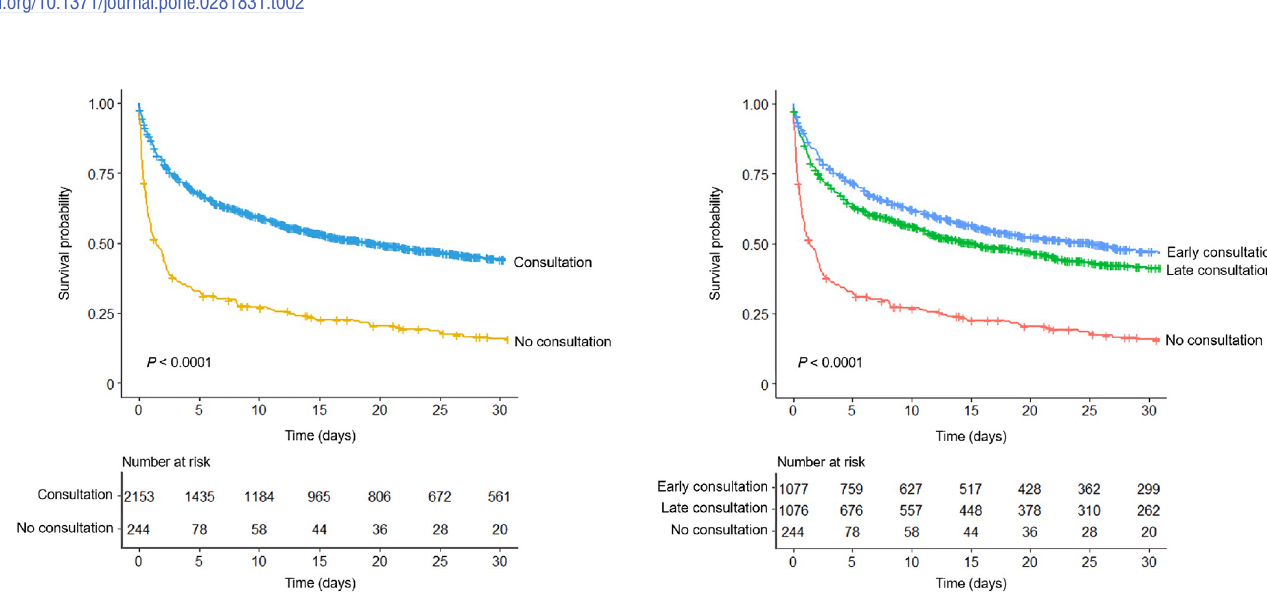
Fig 2. Kaplan–Meier survival curves (A) between consultation and no consultation groups or (B) among early and late consultation and no consultation